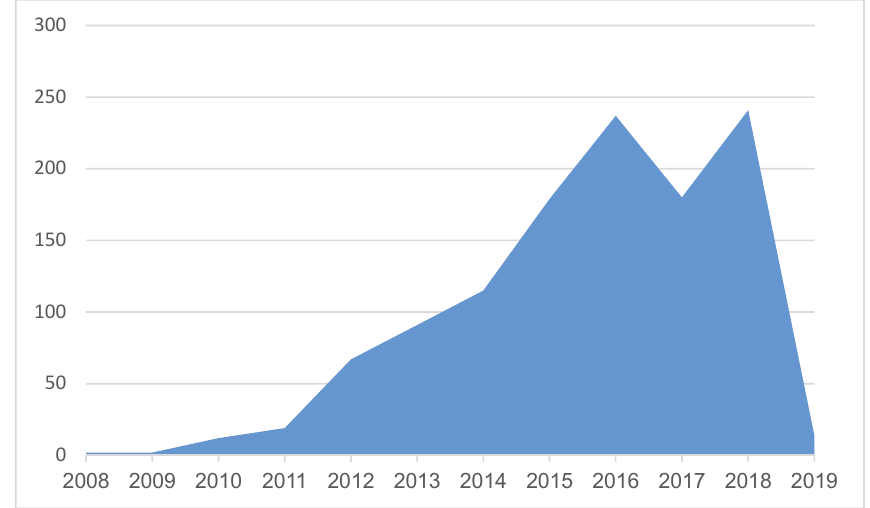
Fig. 1. Annual Scientific